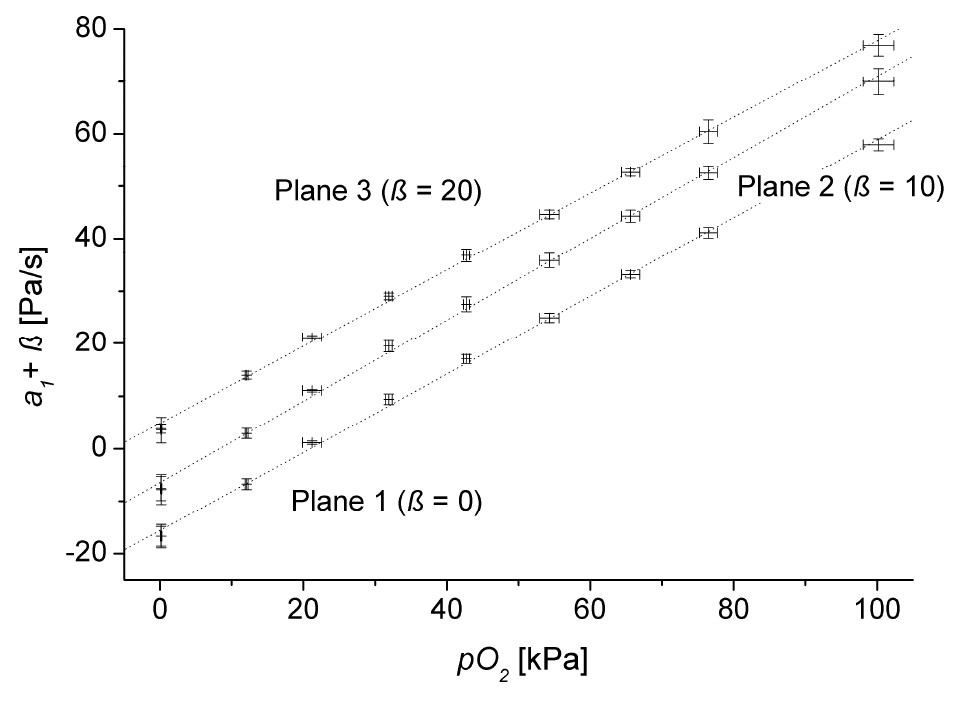
Figure 3. Correlation of pressure change Figure 1) with the partial pressure readability the error bars were formed by the 3-fold standard deviation for both a The records of the different monitoring planes were separated by ß.